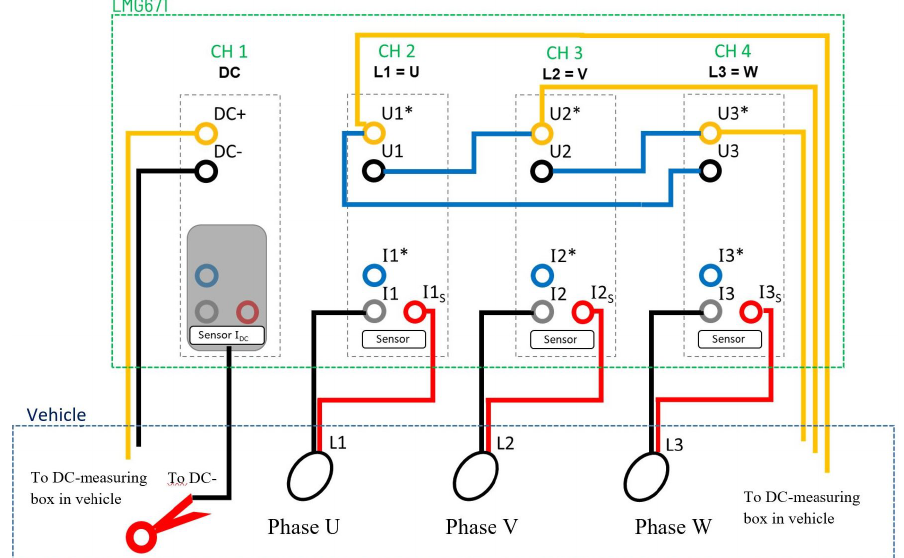
Figure 3. Schematic connections of the LMG671 and the vehicle. CH1 is connected to the DC circuit of the vehicle on the output side of the power electronics and measures the energy flux from the battery to the power electronics or vice versa. The yellow and black connections labeled with DC+ and DC- are